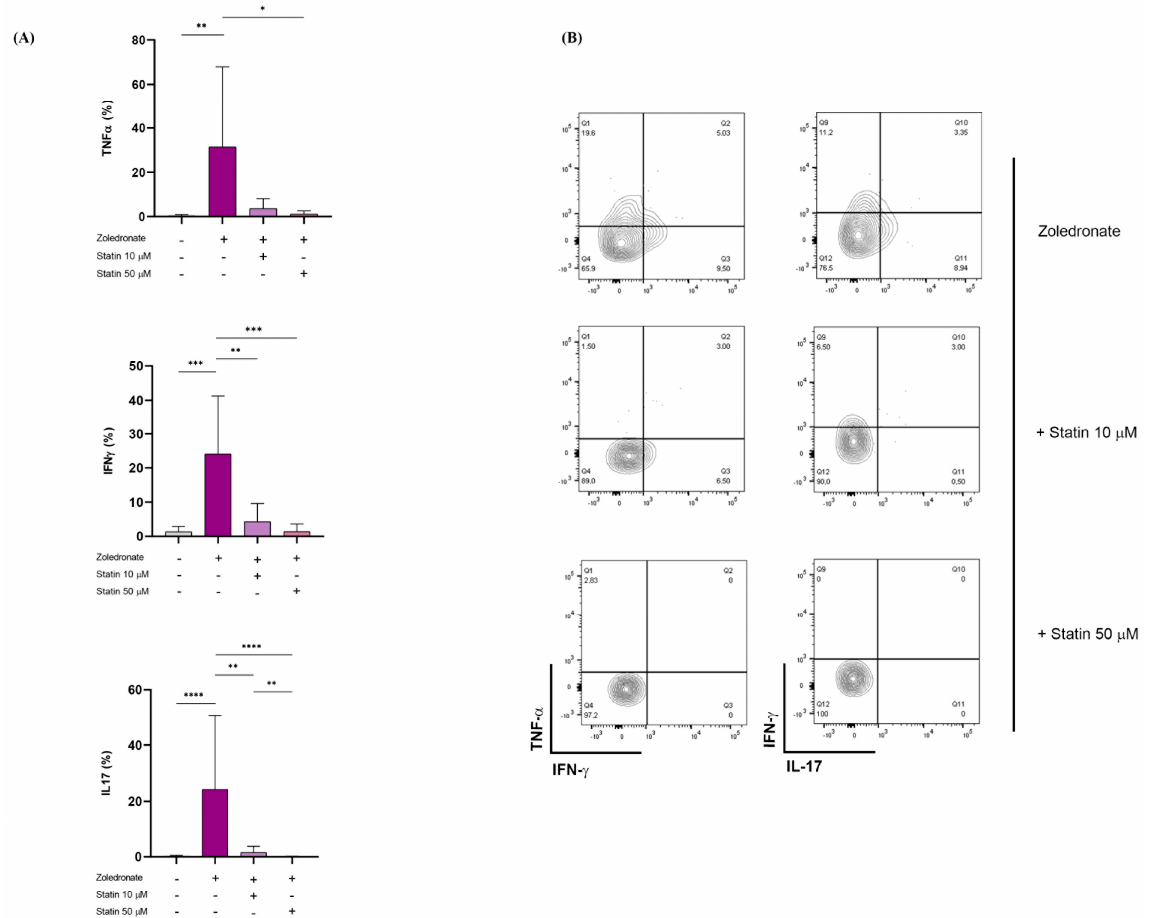
Figure 7. Inhibition of V δ 2+ T cell cytokine expression by atorvastatin upon zoledronate stimulation ( A ) Intracellular levels of TNF- α , IFN- γ , and IL-17 expressed by V δ 2+ T cells from COVID-19 patients upon stimulation with zoledronate in presence of atorvastatin. Data are represented as histogram plots. Each histogram shows mean ± SD. Purple histogram represented Zoledronate condition, lilac histogram represented Zoledronate + 10 µ M statin condition, and pink histogram represented Zoledronate + 50 µ M statin condition. ( B ) Representative counterplots showing pro-inflammatory cytokine expression by V δ 2+ T lymphocytes. * p < 0.05, ** p < 0.01, *** p < 0.001, and **** p <